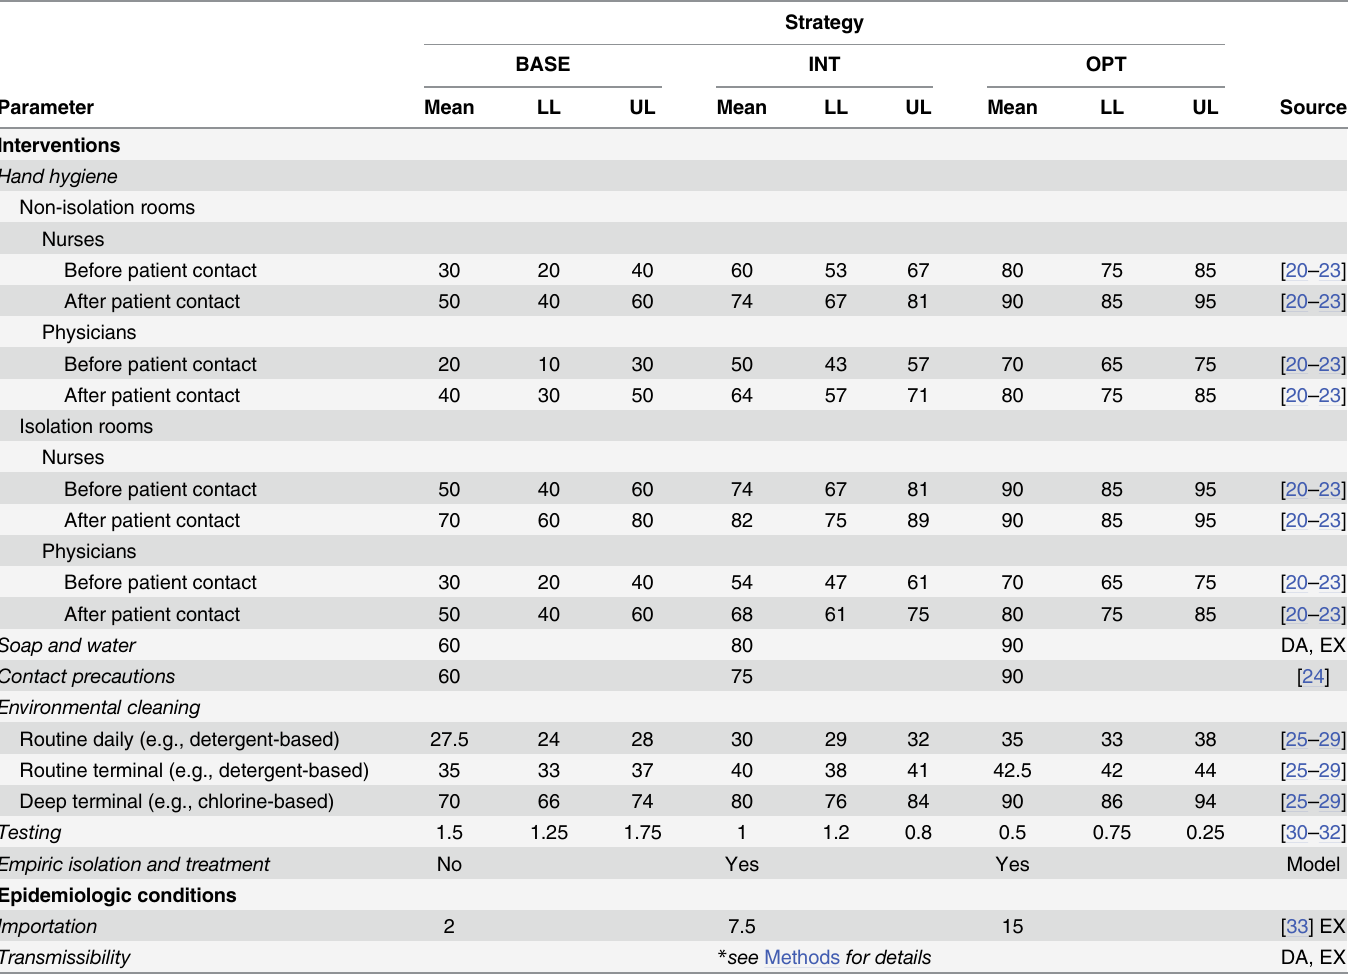
Table 1. Key parameter inputs to simulation